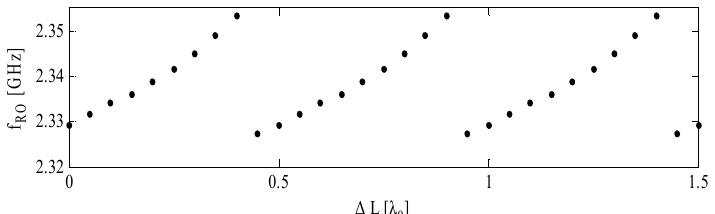
Figure 9. The relationship between RO frequency and variation of external cavity length ∆ L .